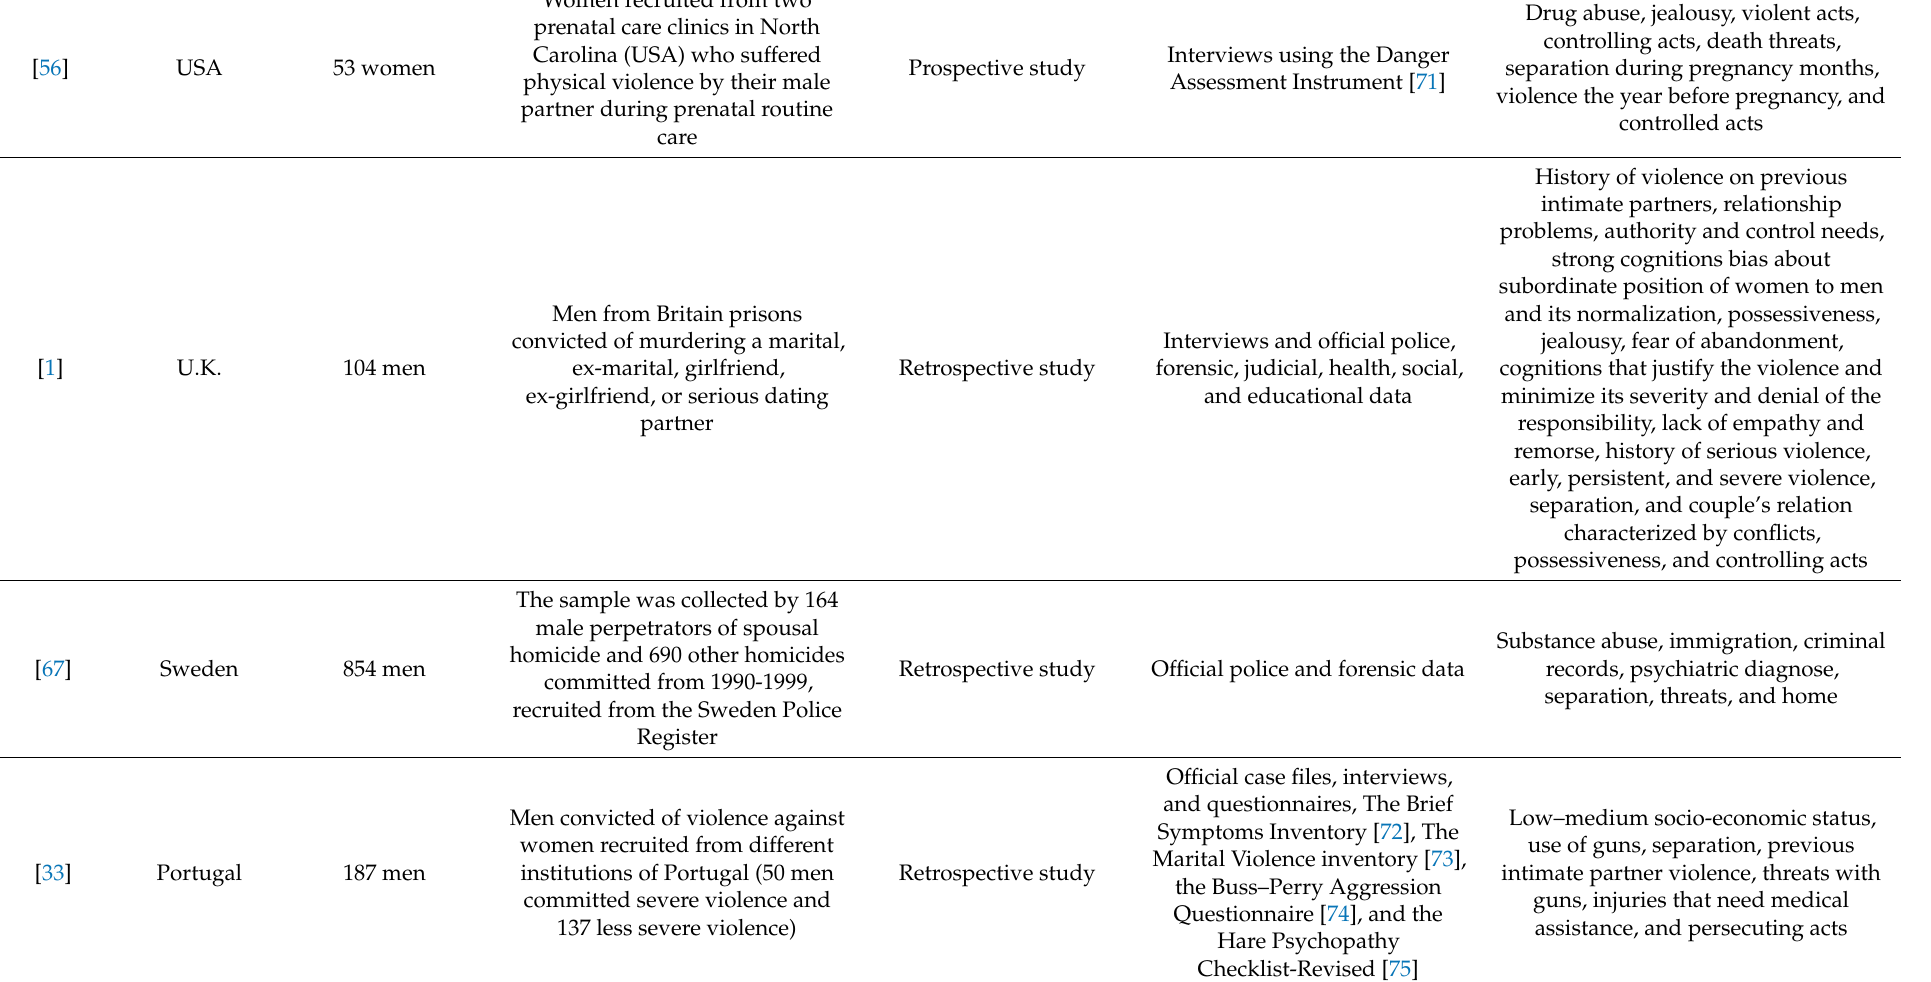
Table 1. Summary of the factors associated with IPF according to the scientific studies.